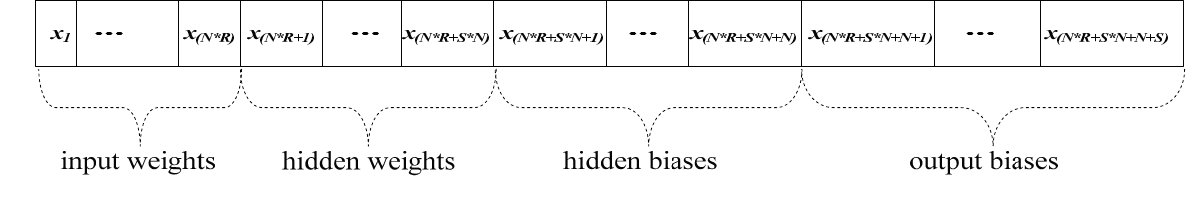
Figure 3. The vector of training